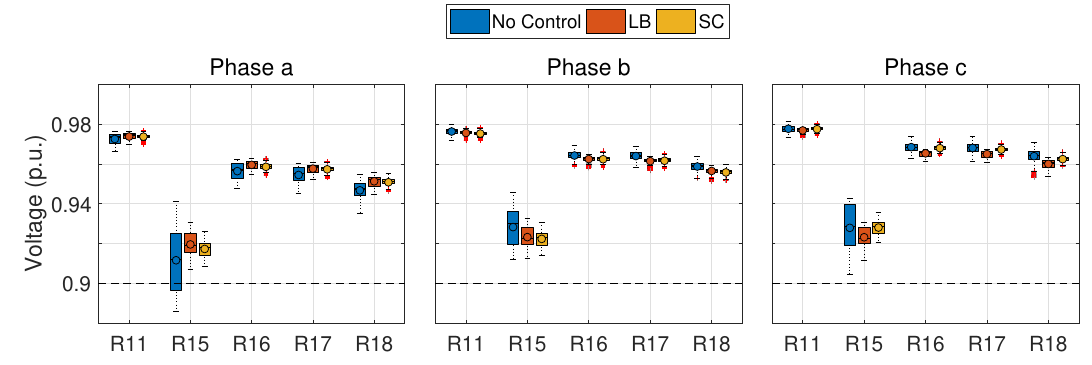
Figure 11. Voltage levels for Scenarios IV, V, and